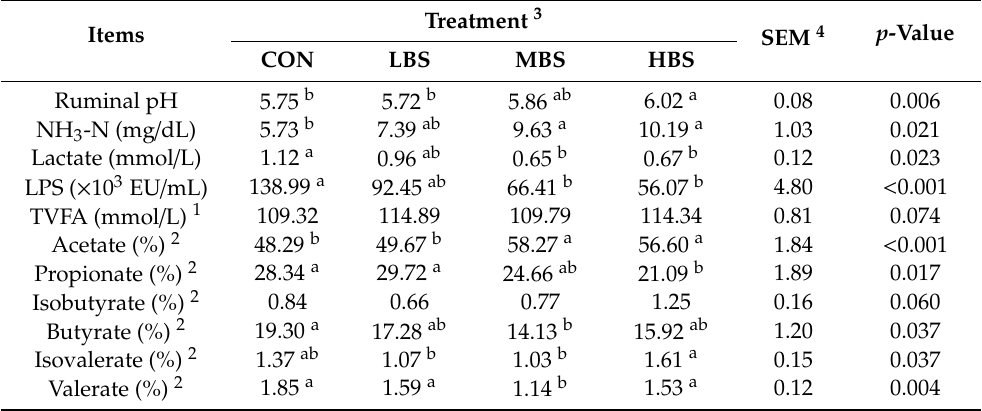
Table 3. E ff ect of dietary β -sitosterol (BBS) supplementation on rumen fermentation parameters of sheep (values averaged across sampling